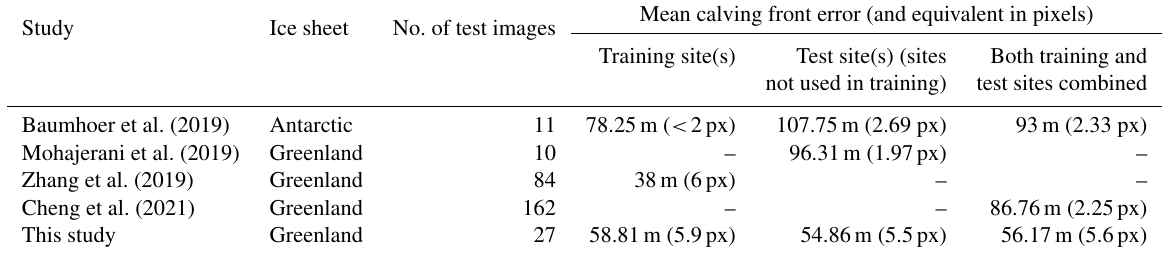
Table 3. Mean calving front errors from previous deep learning methods designed specifically to detect ice fronts in comparison to the mean calving front errors produced by CSC in this